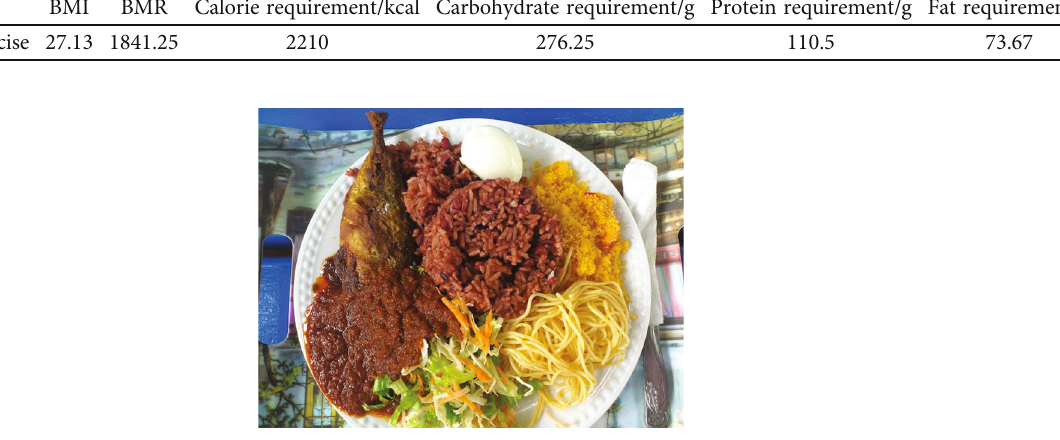
Figure 11: A sample meal selected by a user. Table 9: Sample user data with daily calorie and macronutrient requirements.